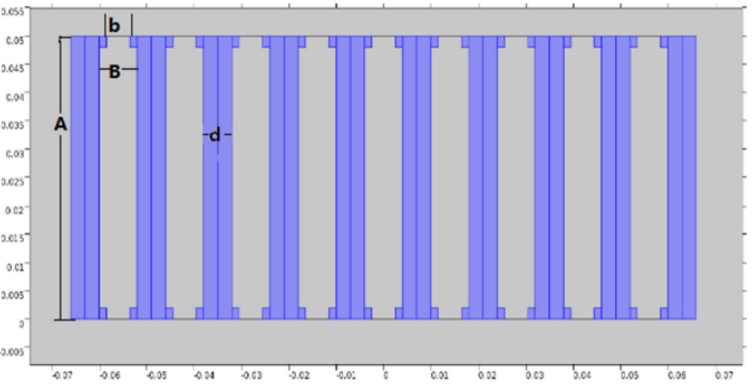
Figure 31. A schematic diagram of an acoustic superlens [98].